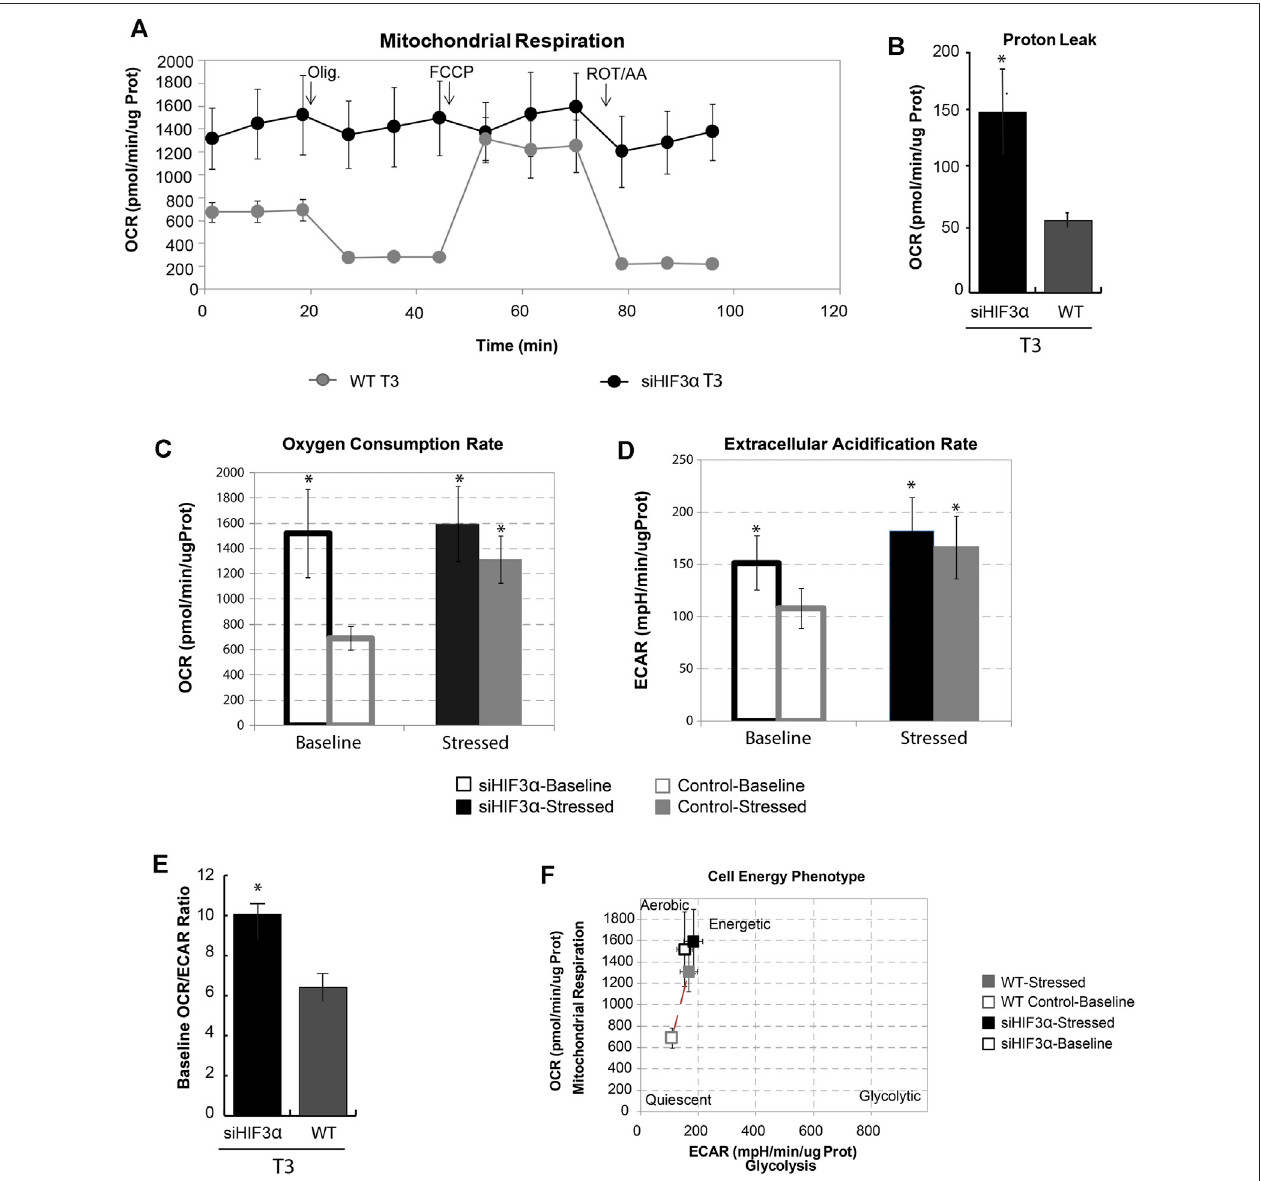
FIGURE 4 | Hif3 α silencing increases mitochondrial respiration. 3T3-L1 cells were transfected with si Hif3 α and induced to differentiate (A) Seahorse analysis showed the Oxygen consumption rate (OCR) expressed in ug protein. (B) Proton Leak. (C) Oxygen Consumption Rate. (D) Extracellular Acidi fi cation Rate. (E) Baseline OCR/ECAR ratio (F) Mitochondrial respiration vs. glycolysis. Values are mean ± SD ( n (cid:2) 3; * p < 0.05 vs . WT or control cells).